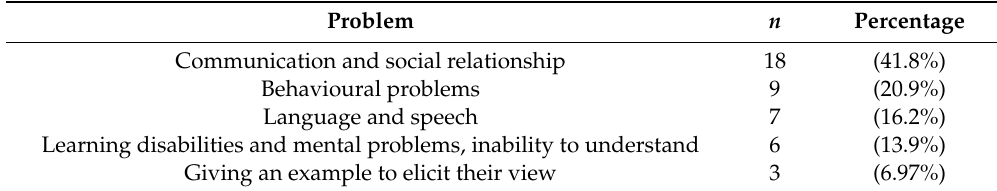
Table 3. The present problem of the children from the parents’